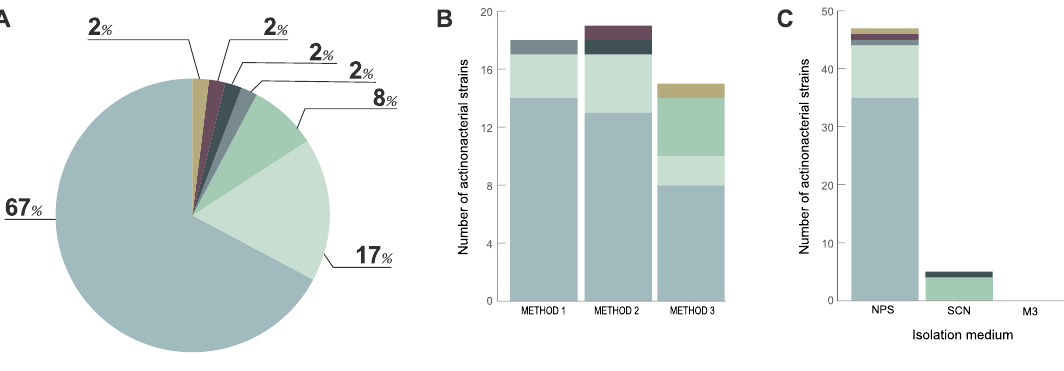
Figure 1. Distribution, in terms of genera, of the Actinobacteria strains recovered from the marine sediment collected at Parque Natural do Litoral Norte, northern Portugal, according to abundance, treatment methods and selective culture media used. ( A ) Percentage of recovered isolates belonging to indicated genera; ( B ) number of isolates a ffi liated with indicated genera recovered from the three treatment methods employed (Method 1, No treatment; Method 2, Water bath at 60 ◦ C for 5 min; Method 3, Antibiotics (20 ppm) and water bath at 28 ◦ C for 30 min); ( C ) number of isolates belonging to indicated genera recovered from to the three selective culture media